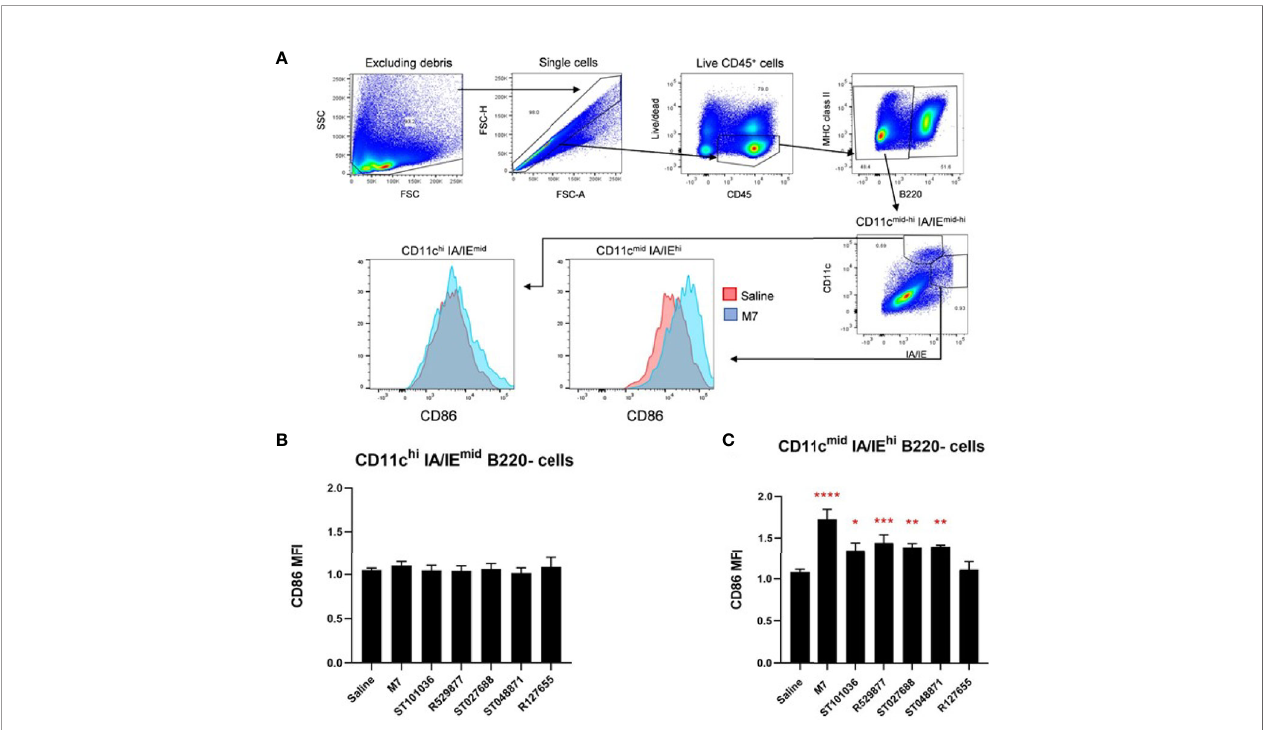
FIGURE 8 | Mast cell activators enhance co-stimulatory molecules on dendritic cells in the draining cervical lymph nodes. Mouse resident and migratory dendritic cells in the draining cervical lymph node were monitored for CD86 expression after exposure to 200 nmoles of the mast cell activating compounds (ST101036, R127655, R529877, ST027688, ST048871), M7 (positive control), or saline (negative control). The gating strategy used to identify the cell populations is presented in (A) . Resident DCs are characterized as CD11c hi and MHCII mid (B) and Migratory DCs are characterized as CD11c mid and MHCII hi populations (C) .